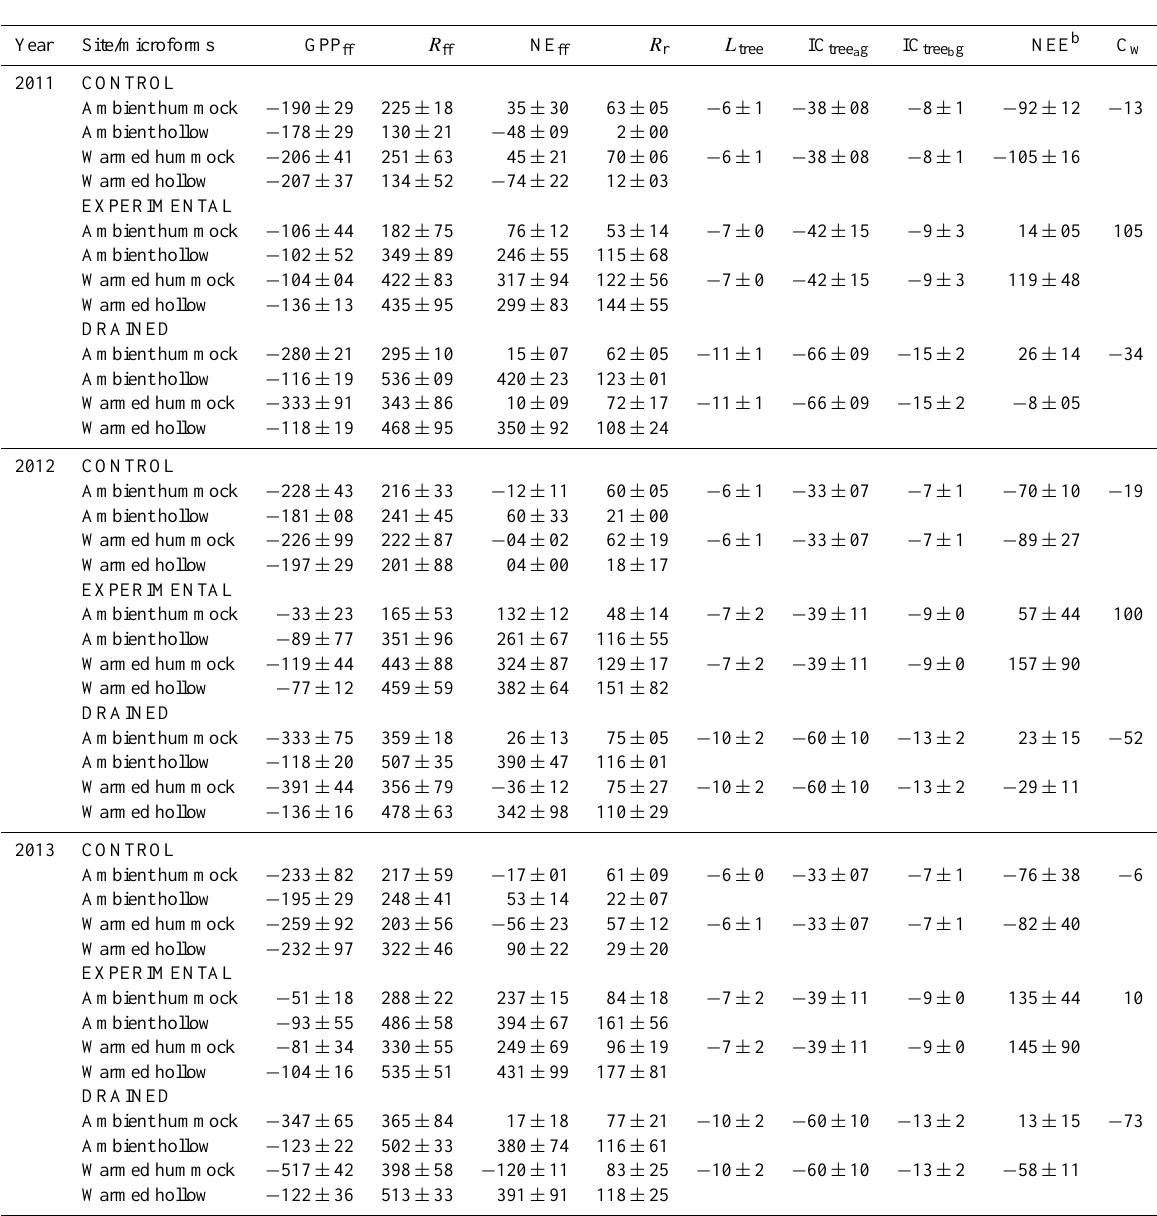
Table 4. Growing season CO 2 –C flux estimates ( ± SE; gCO 2 –Cm − 2 ) a